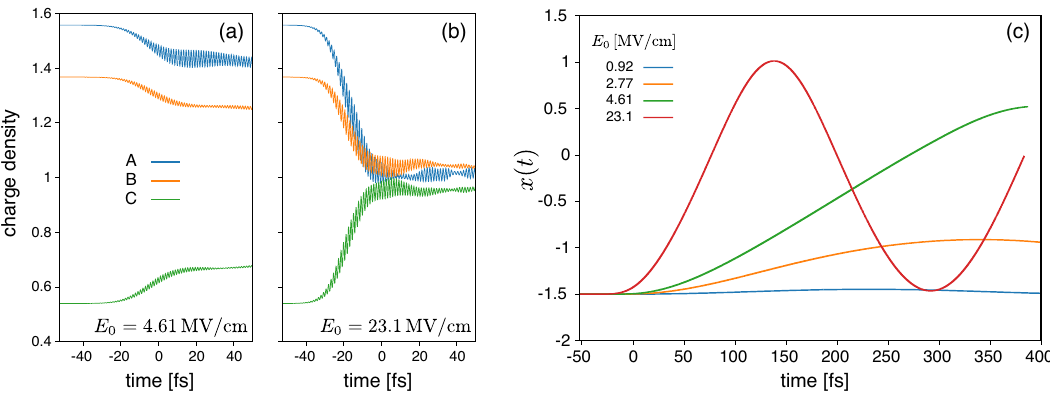
Figure 7. Time profiles of charge densities averaged over A, B, and C sites for laser amplitudes ( a ) E 0 = 4.61 and ( b ) 23.1MV/cm; ( c ) time profile of lattice distortion x ( t ) for several laser amplitudes E 0